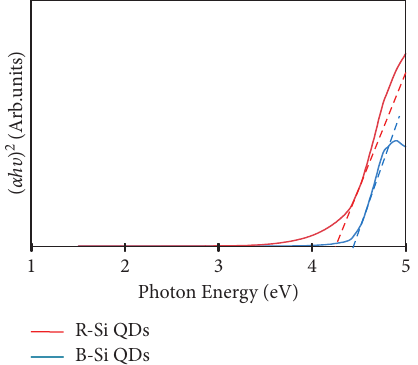
Figure 7: The PL emission of colloidal B-Si QDs (a) and R-Si QDs (b) by comparison with quinine sulfate in 0.05M H 6G in ethanol, respectively.